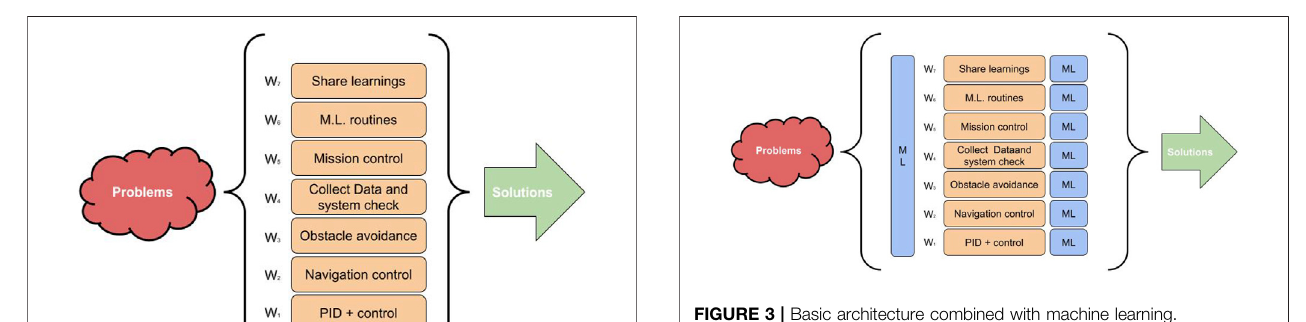
FIGURE 3 | Basic architecture combined with machine